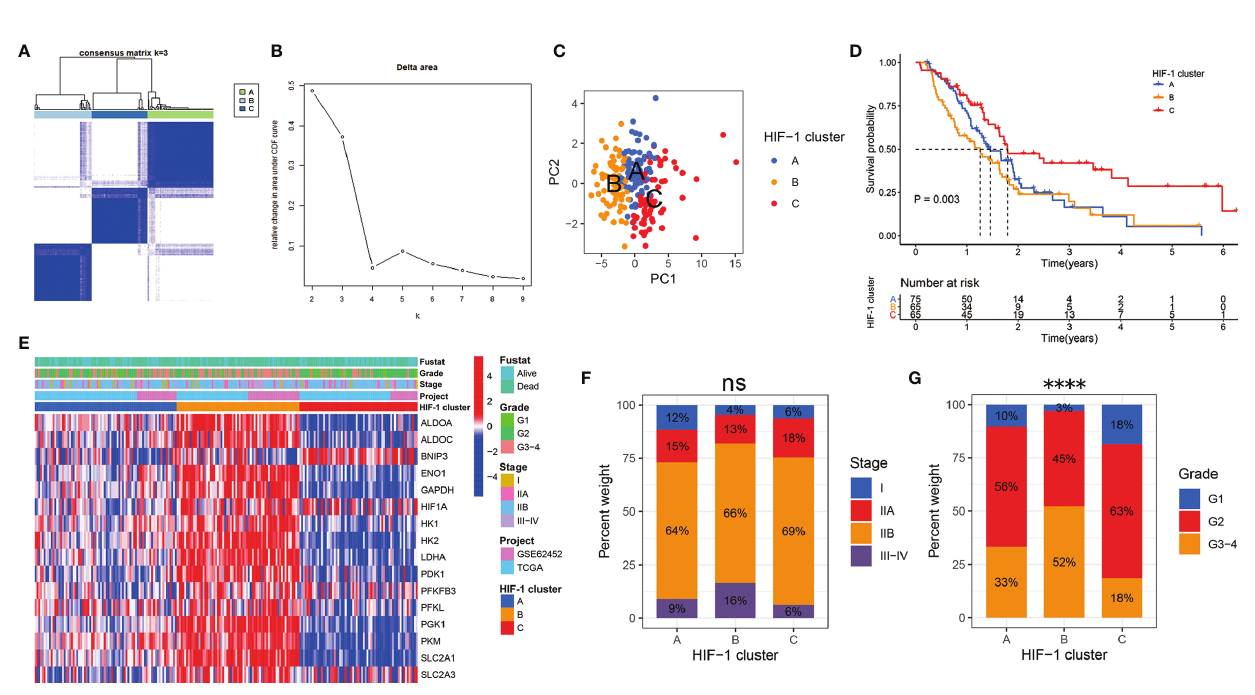
FIGURE 1 | Consensus clustering analysis identi fi ed three HIF-1 clusters of PDAC with different clinical outcomes. (A) The meta-PDAC cohort was divided into three distinct clusters when k = 3. (B) Relative change in area under consensus clustering cumulative distribution function curve for k = 2 to 9. (C) PCA demonstrated that HIF-1 related genes worked well with signi fi cant clustering ef fi cacy. (D) The KM survival curve for OS showed a signi fi cant difference among these three HIF-1 clusters. (E) Heatmap to show the 16 HIF-1 related genes expression and corresponding clinicopathological information in the three HIF-1 clusters. (F) HIF-1 cluster was not signi fi cantly associated with AJCC stage. (G) HIF-1 cluster was signi fi cantly associated with histologic grade. PDAC, pancreatic ductal adenocarcinoma; PCA, principal component analysis; KM, Kaplan-Meier; OS, overall survival; AJCC, American Joint Committee on Cancer. ns > 0.05; ****P value <